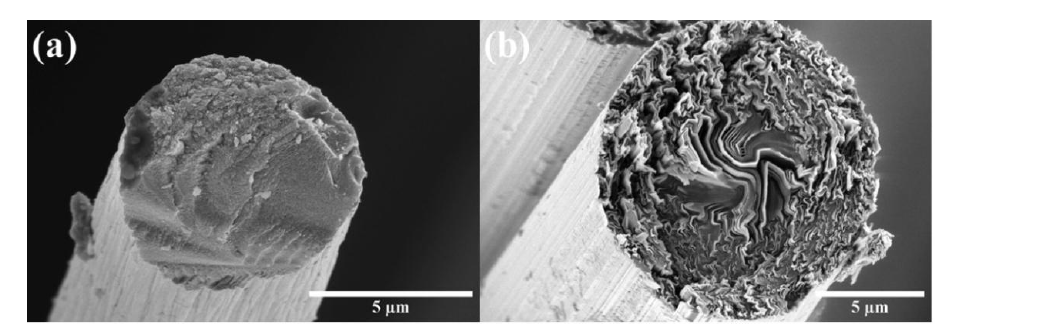
Fig. 3 Microstructures of cross-sections: (a) T300 and (b)